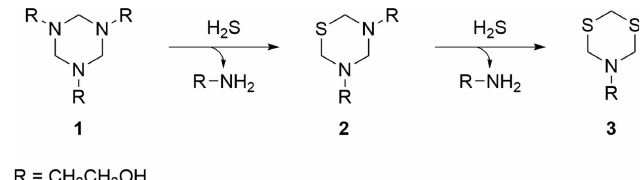
Figure 1 Reaction of hydrogen sulfide with 2-(1,3,5-dithiazinan-5-yl)ethanol (MEA-triazine) ( 1 ) to yield the MEA mono- ( 2 ) and dithiazine ( 3 )